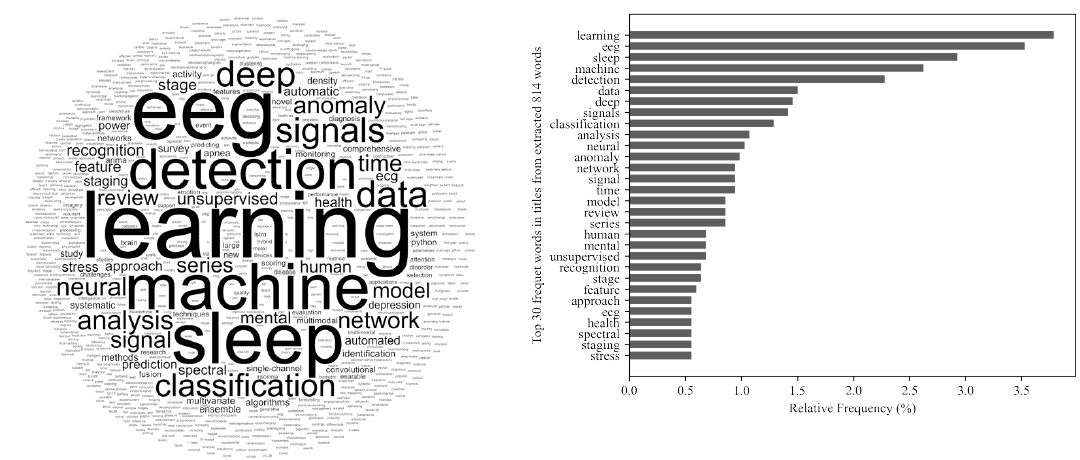
Figure 3. Word cloud and bar graph of the titles of the articles used in this review.